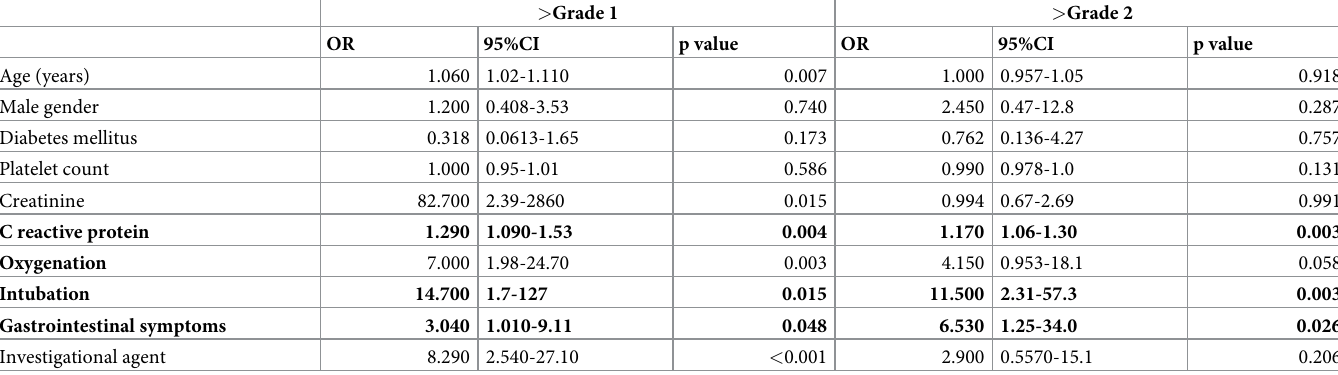
Table 2. Logistic regression analysis for factors associated with liver injury in COVID-19 patients.